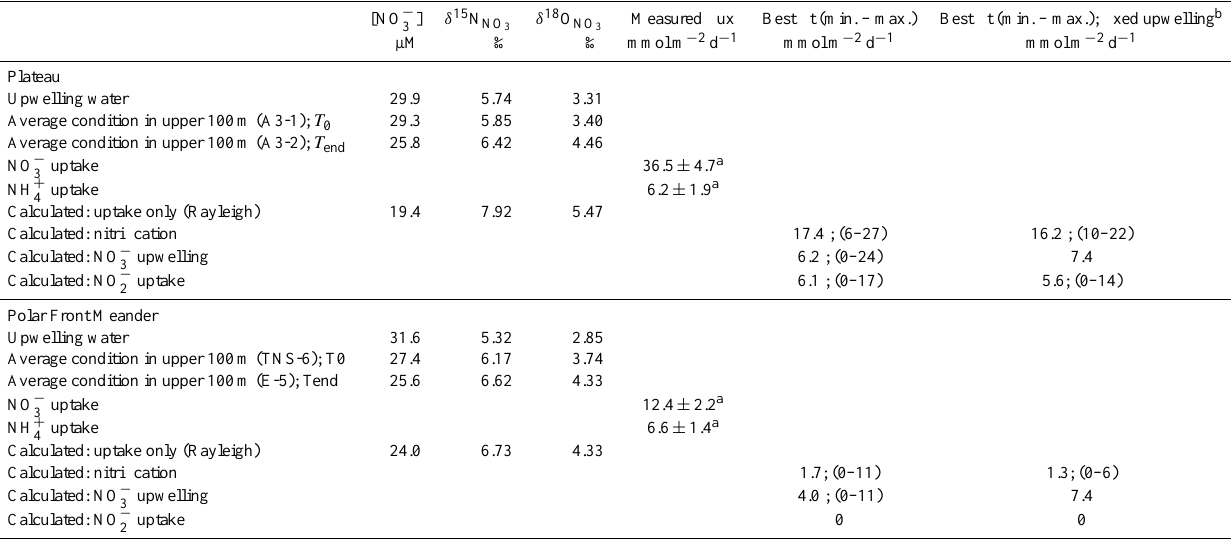
Table 3. Plateau and Meander sites: Observed initial and final conditions of nitrate concentration and isotopic composition; Observed nitrate and ammonium uptake rates (from Cavagna et al., 2014); Calculated nitrification, nitrite uptake, nitrate upwelling rates required to explain the observed nitrate isotopic composition and nitrate concentration at the end of the considered growth